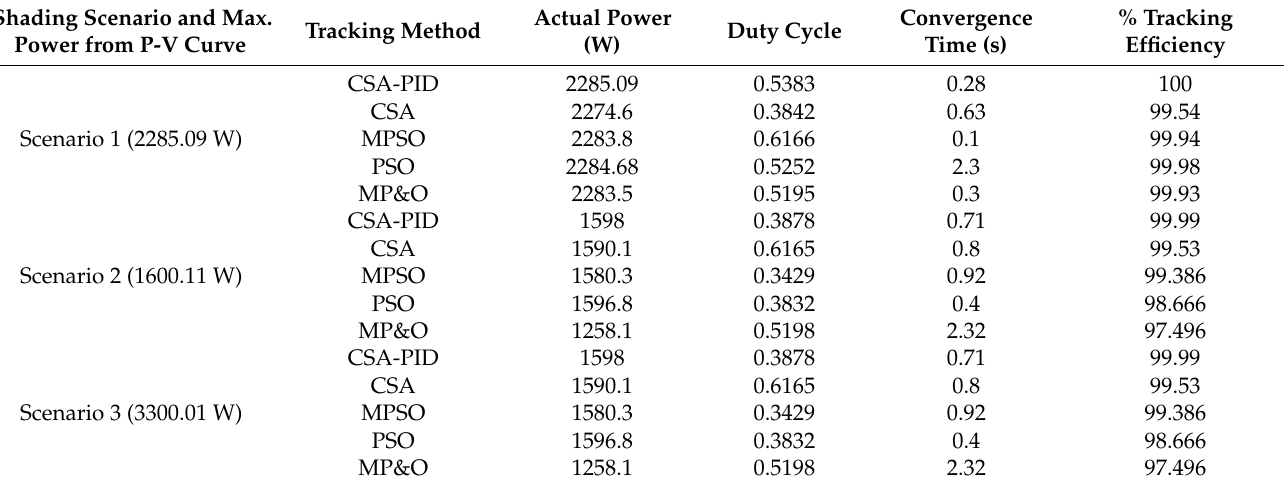
Table 6. Power, duty cycle tracking time, and the efficiency values comparison between the actual values of CSA-PID, CSA, MPSO, PSO, and